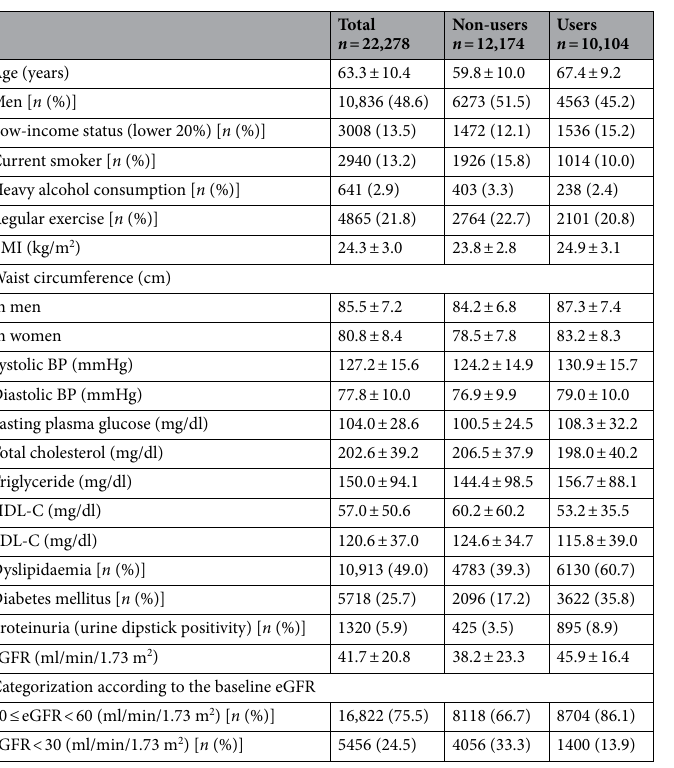
Table 1. Baseline characteristics of the study participants according to antihypertensive agent use. BMI body mass index, BP blood pressure, HDL-C high-density lipoprotein cholesterol, LDL-C low-density lipoprotein cholesterol, eGFR estimated glomerular filtration rate. Data are expressed as mean ± standard deviation (continuous variables) or n (%) (categorical